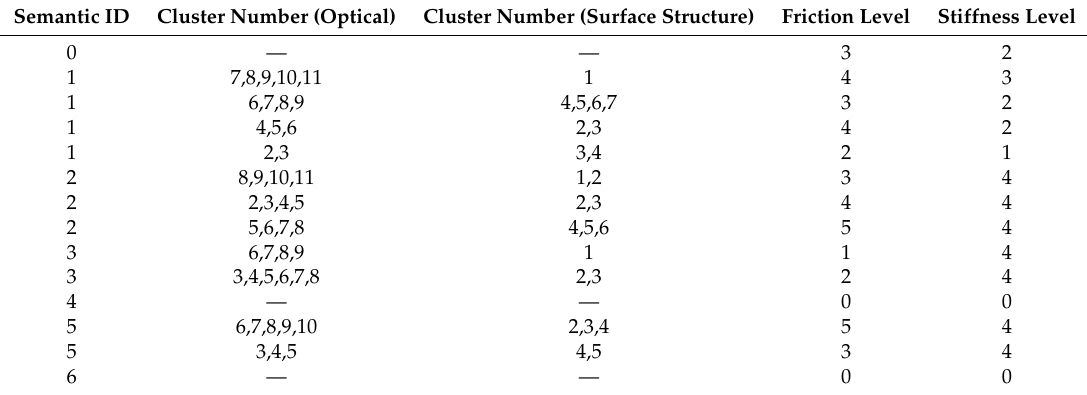
Table 7. Some examples of the dataset for mapping relationships from terrain types to physical